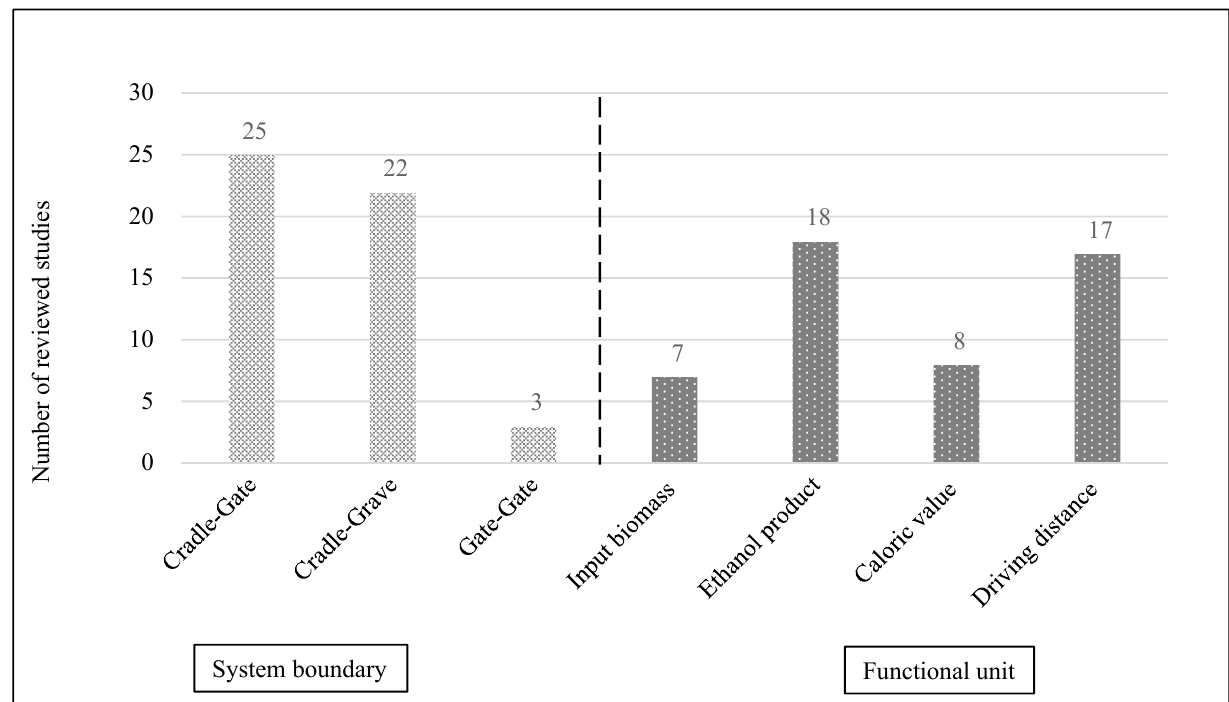
Figure 4. Number of reviewed papers in each selected functional unit and system boundary (some of studies chose more than one FU).